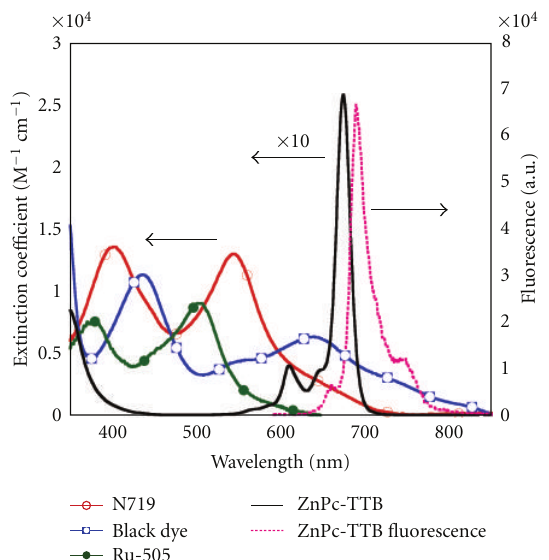
Figure 18: Absorption spectra of donor and acceptor dyes and emission spectrum of phthalocyanine donor. For display purposes, 0.1 times the extinction coe ffi cient of ZnPc-TTB is shown. Reprinted with permission from [9].